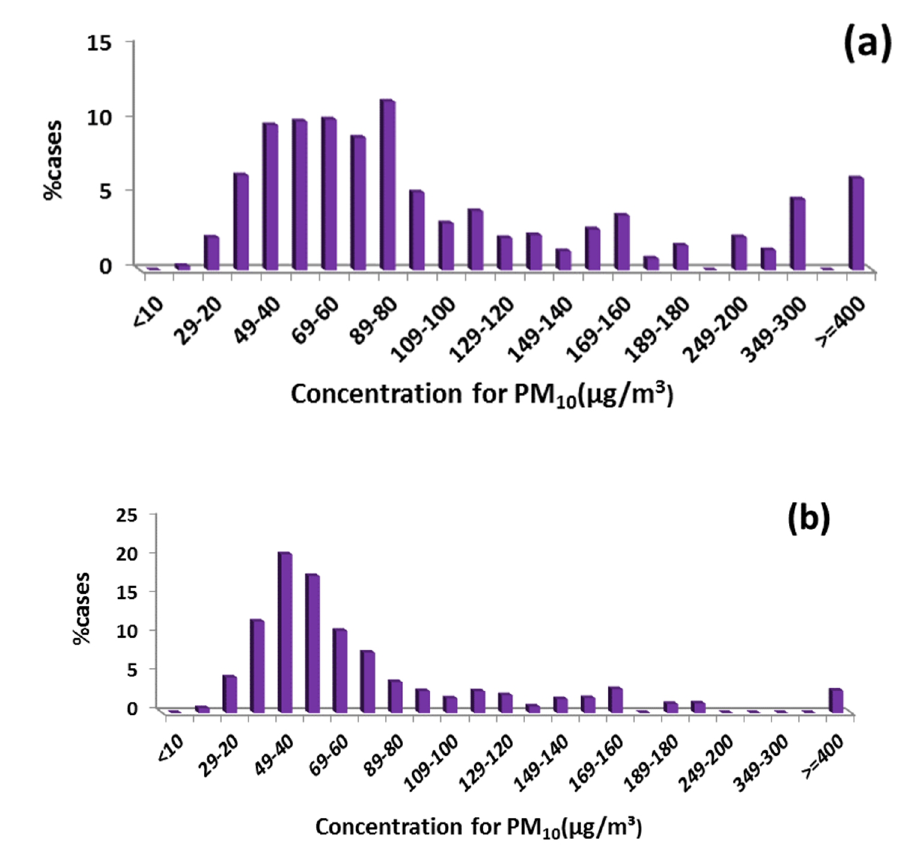
Fig. 4. Percentage of people exposed to different concentrations of particles with an aerodynamic diameter of less than 10 microns in 2013 (a) and 2014